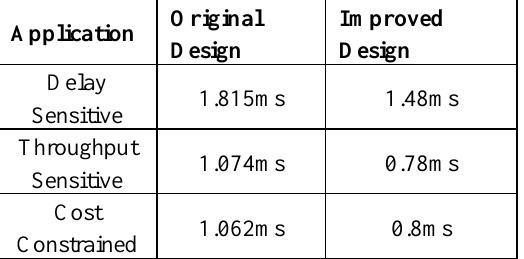
Table 3. Average calculation time for Bluetooth